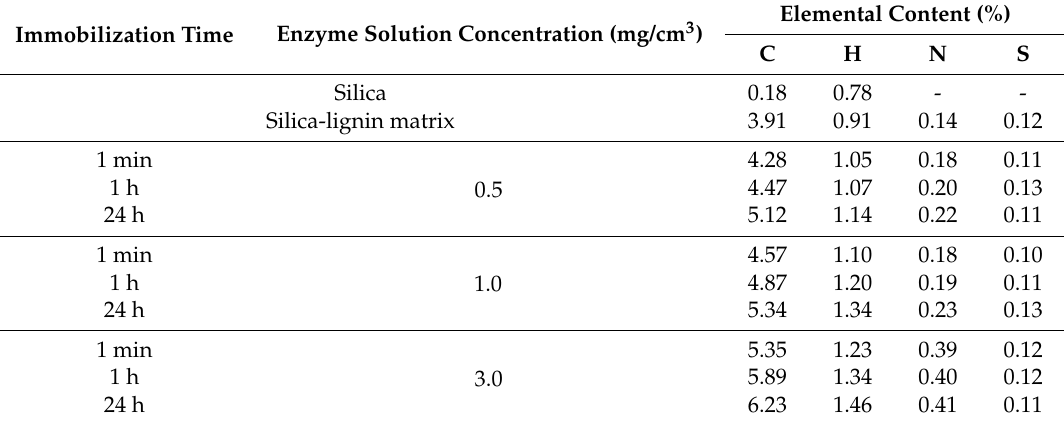
Table 2. Elemental composition of silica, silica-lignin materials and products following immobilization.